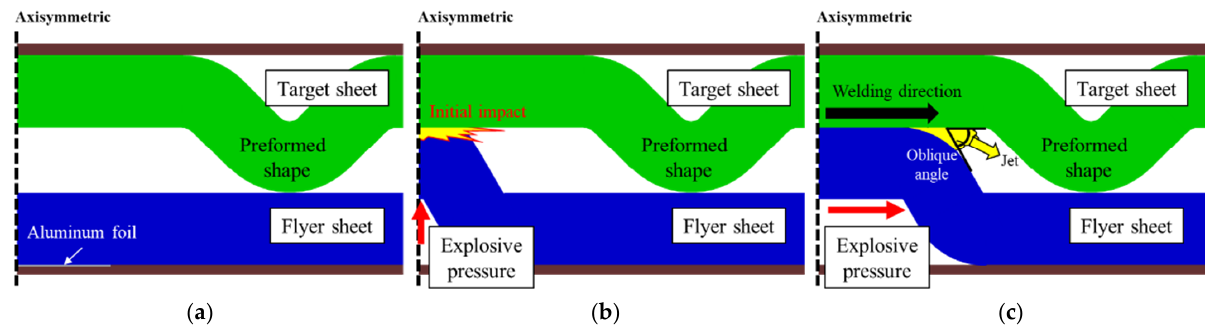
Figure 7. Welding mechanism of the standoff-free VFAW test: ( a ) initial set-up by applying preform target sheet; ( b ) initial impact; ( c ) continuous welding mechanism after initial impact.